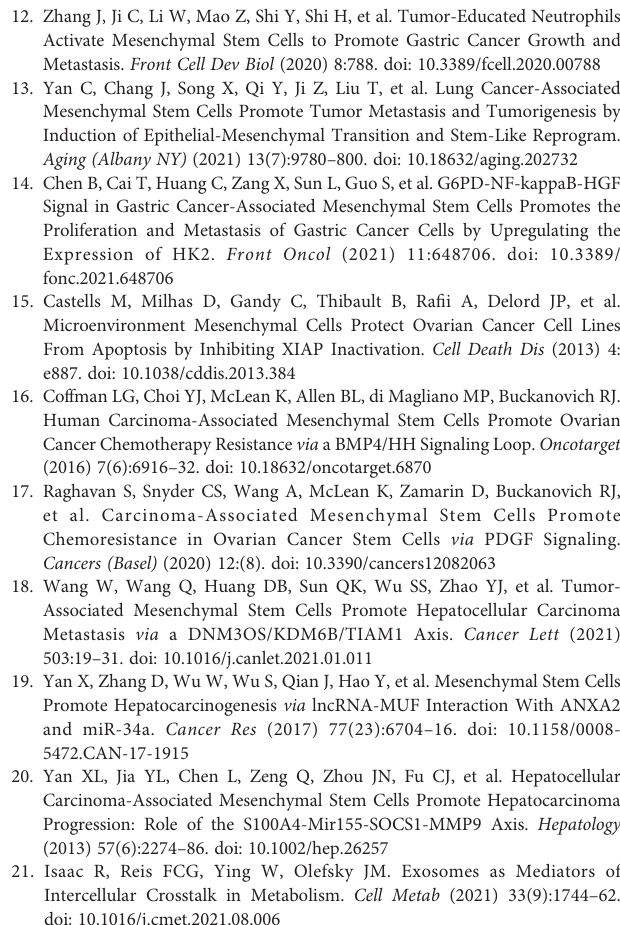
Supplementary Figure 1 | Characterization of HCC-MSCs and their derived exosomes. HCC-MSCs under bright fi eld (A) ; surface markers of HCC-MSCs (B) ; particle size analysis of HCC-MSCs derived exosomes (C) ; exosome marker analysis (D) ; observation of exosomes absorbed by HCC cells (E) . Supplementary Figure 2 | Effect of HCC-MSCs on migration of HCC cells. Representative images of migration detection (A) ; Comparison of migration rate between groups (B) . Supplementary Figure 3 | RNA sequencing in Huh7 cells. PCA (A) , heatmap (B) and volcano plot ( C ) analyses between MSC_Exo group and normal group; GO (D) and KEGG (E) enrichment of DEGs between MSC_Exo group and normal group. PCA (F) , heatmap ( G ) and volcano plot (H) analyses between MSC group and MSC_GW group; GO (I) and KEGG (J) enrichment of DEGs between MSC group and MSC_GW group. Supplementary Figure 4 | GO and KEGG enrichment of DEGs between MSC_Exo versus normal groups and MSC versus MSC_GW